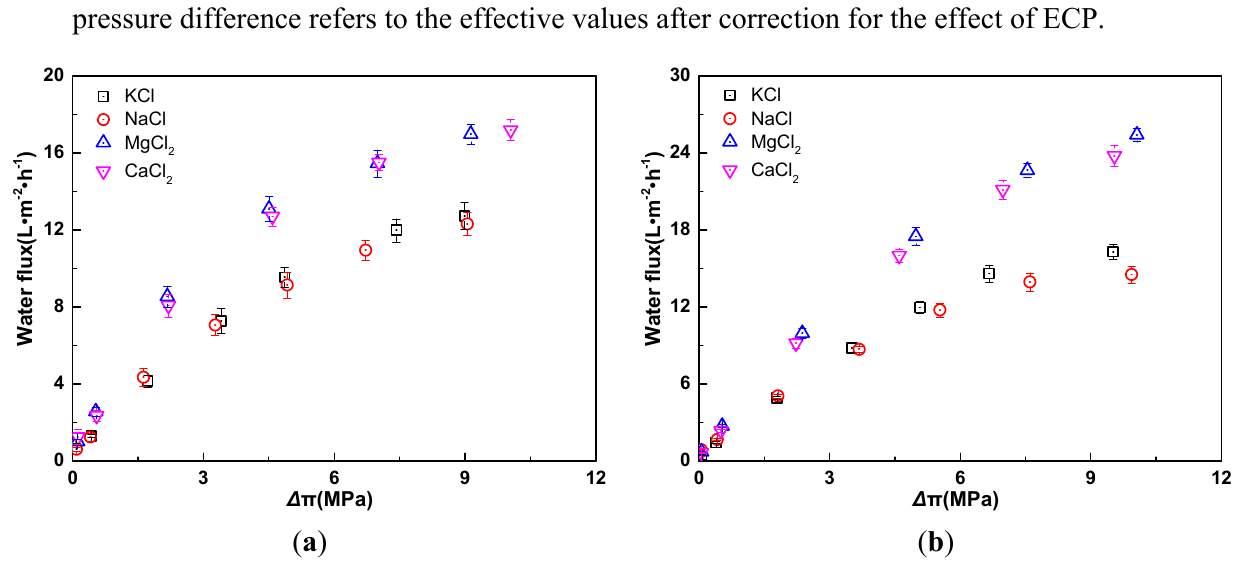
/ C = 8; ( b ) C = 0.01 M. The osmotic d f f